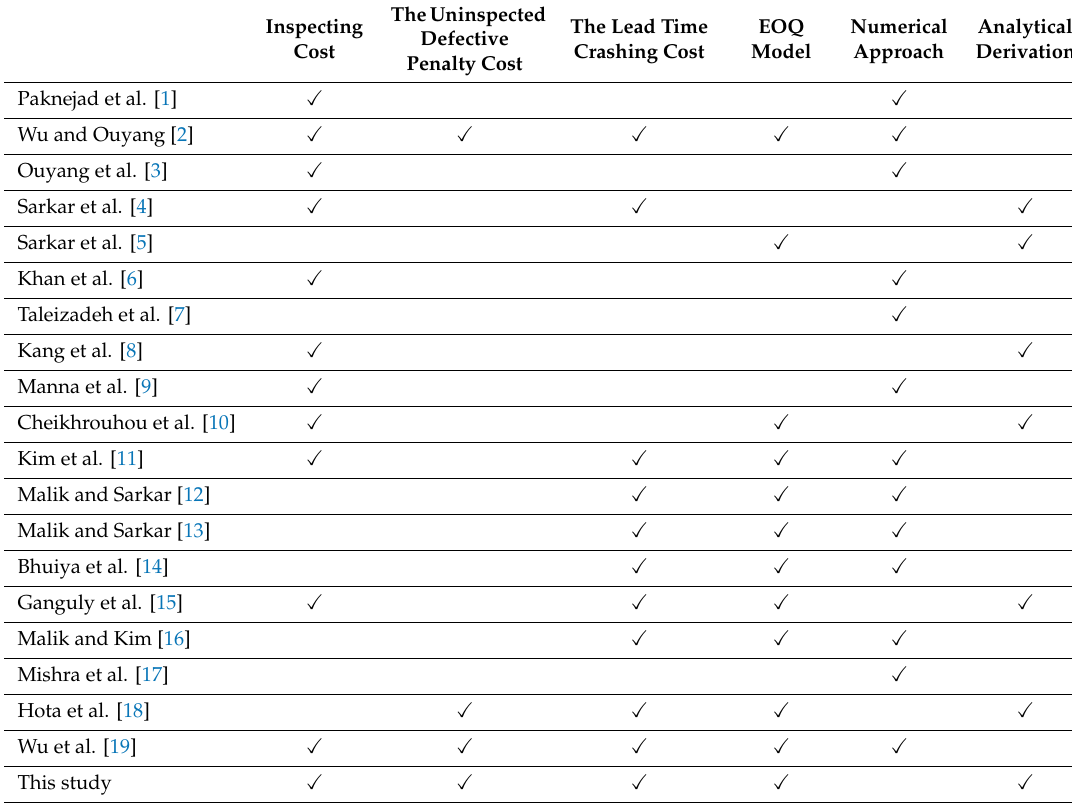
The Lead Time Crashing Cost